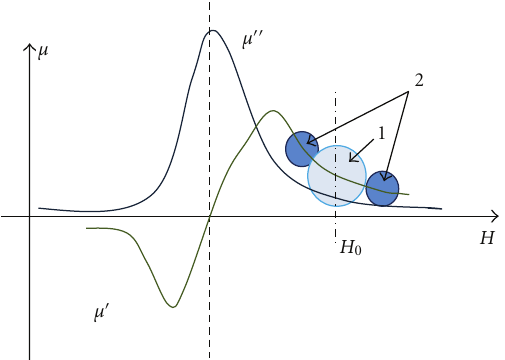
Figure 9: Typical ferromagnetic resonance regime for YIG showing the real and imaginary parts of the permeability as a function of bias field H 0 . The change in the permeability and phase with H 0 or E is linear in region 1 and is nonlinear in region